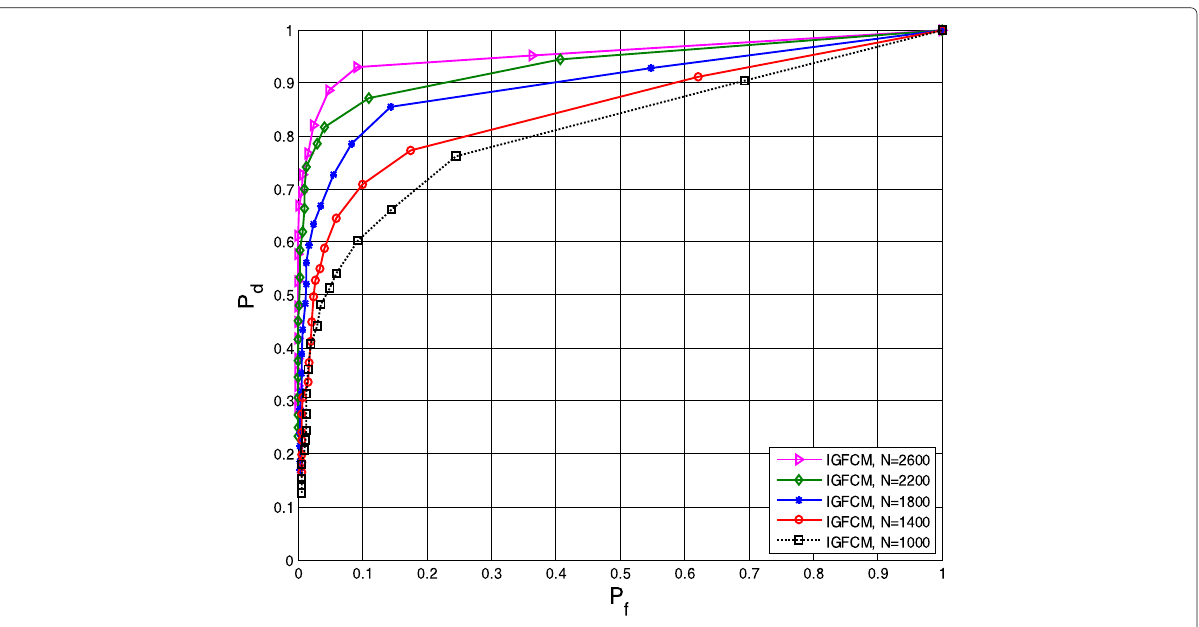
Fig. 9 ROC curve at different sampling points with SNR = − 13